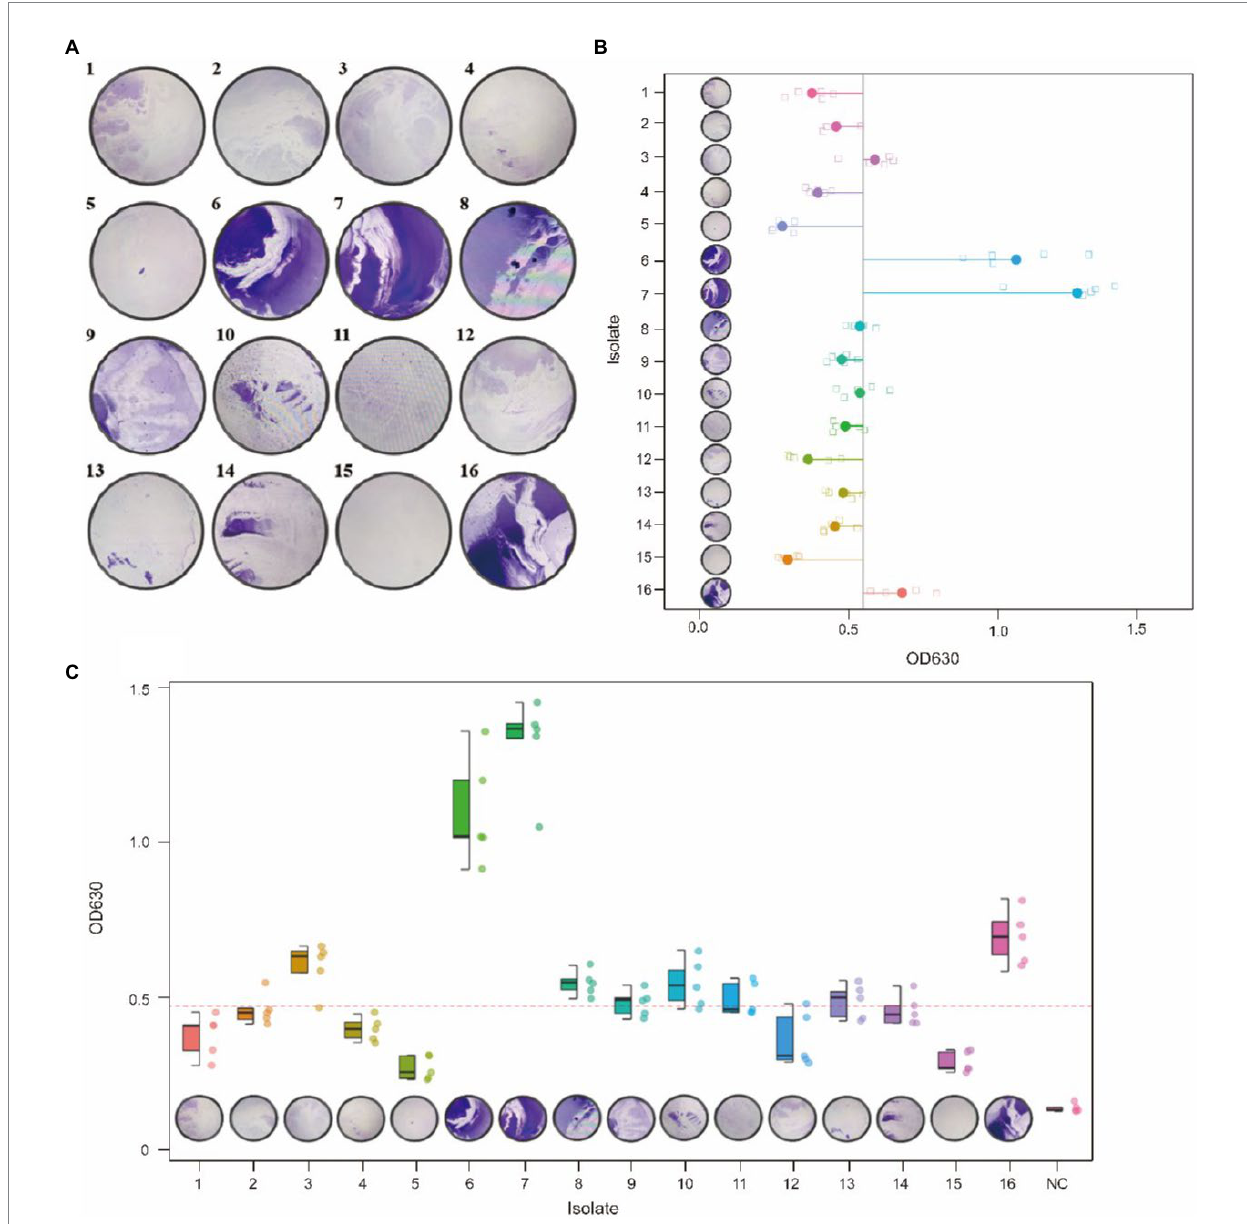
FIGURE 8 Crystal violet staining of biofilms of 16 G. parasuis strains (A) . One represents strain GP 01, others are analogous; the picture was taken from the biofilm formed on a 9 cm × 9 cm polystyrene petri dish. Comparison of biofilm forming ability of 16 G. parasuis strains (B,C) . (B,C) Described the minimum,